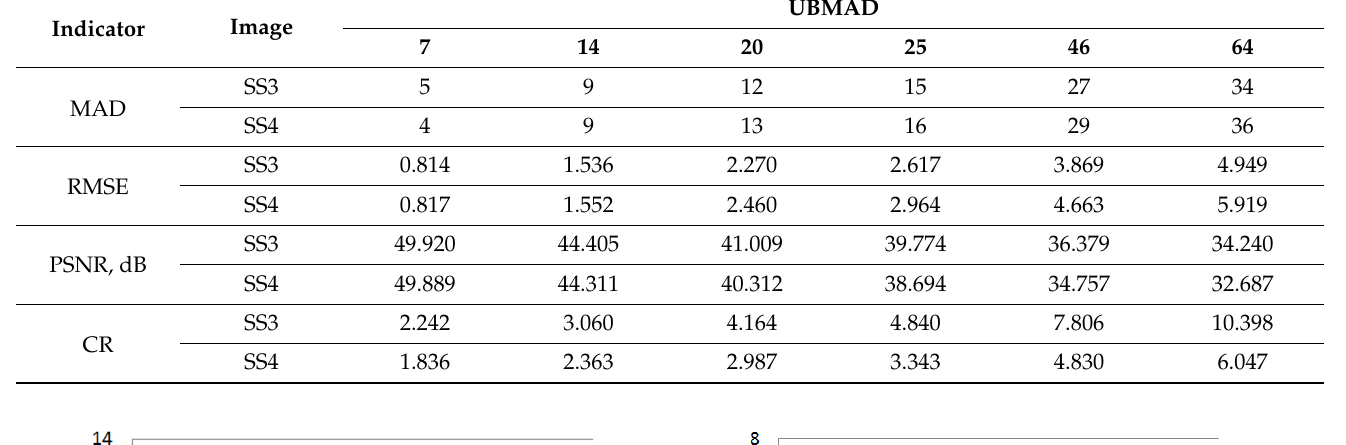
Figure 12. Test images SS3 ( a ) and SS4 ( b ): real life Sentinel-2 images for country-side ( a ) and city